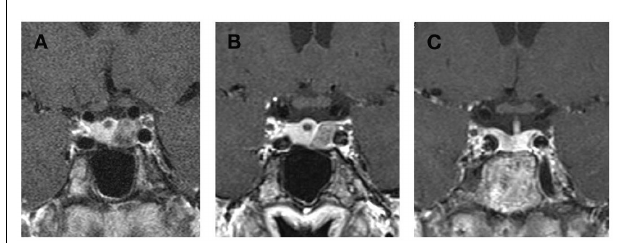
FIGURE 2 | Evolution of the adenoma on long-acting octreotide therapy (A,B) and result of trans-sphenoidal surgery [(C), i.e., 17months after surgery]. (A) MRI November 2007 (CoronalT1 after gadolinium injection): oval hypointense nodule in the left lobe of pituitary gland, measuring 10mm on 6mm. No invasion of the cavernous sinus. Small cyst at the root of the pituitary stalk. (B) MRI March 2009 (CoronalT1 after gadolinium injection): in comparison to November 2007, small decrease (under long-acting octreotide therapy) of left microadenoma, still in contact with the left cavernous sinus (without any sign of invasion). (C) MRI August 2010 (CoronalT1 after gadolinium injection): the adenoma has been removed leaving only minor scar tissue in the left anterior pituitary lobe.The small cyst has gradually